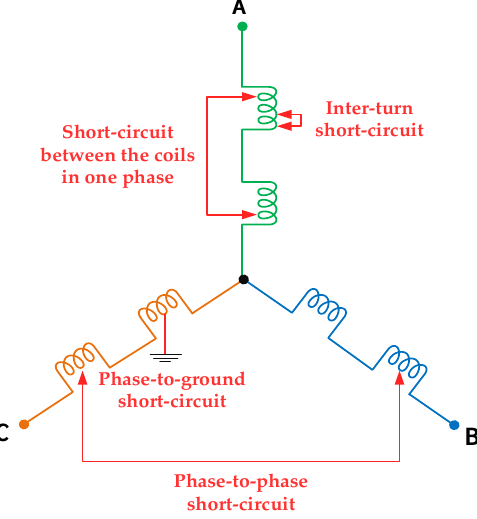
Figure 1. PMSM stator winding short-circuit types.